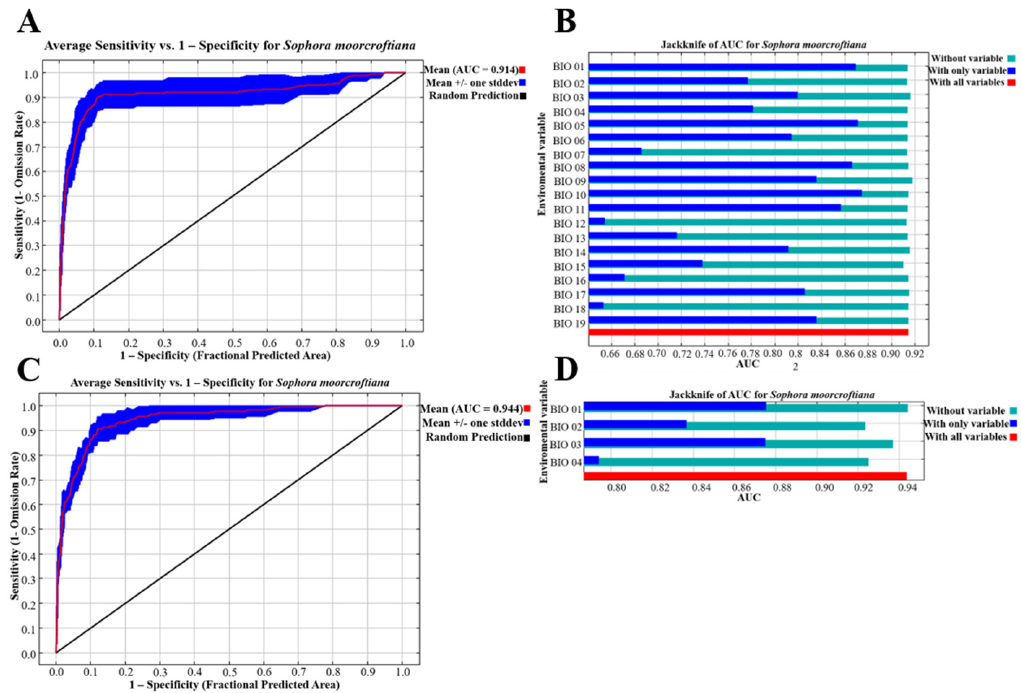
Figure 5. ( A ) ROC curve of MaxEnt model simulation results of all climate variables; ( B ) ROC curve of MaxEnt model simulation results of the selected climate variables; ( C ) Jackknife test for evaluating the relative importance of all climate variables on the distribution of S. moorcroftiana ; ( D ) Jackknife test for evaluating the relative importance of the selected climate variables on the distribution of S. moorcroftiana.